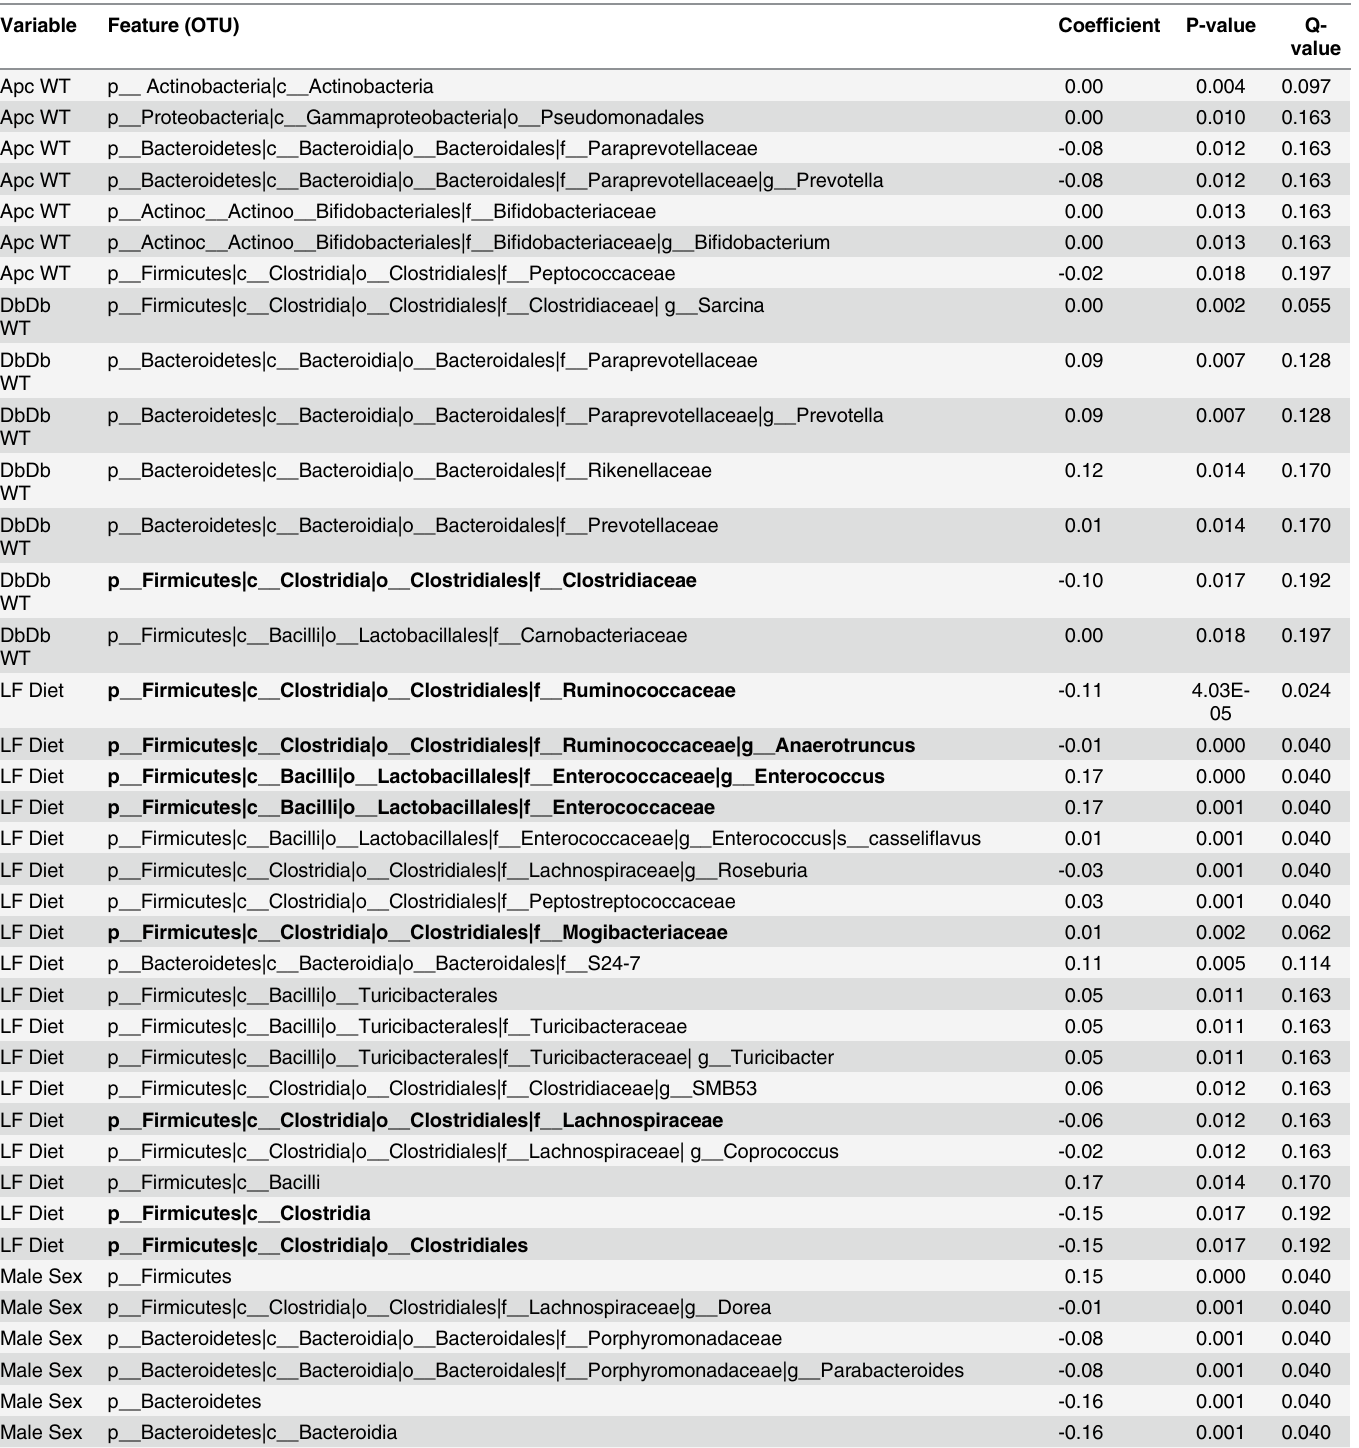
Table 3. Multivariate Association with Linear Models (MaAsLin)